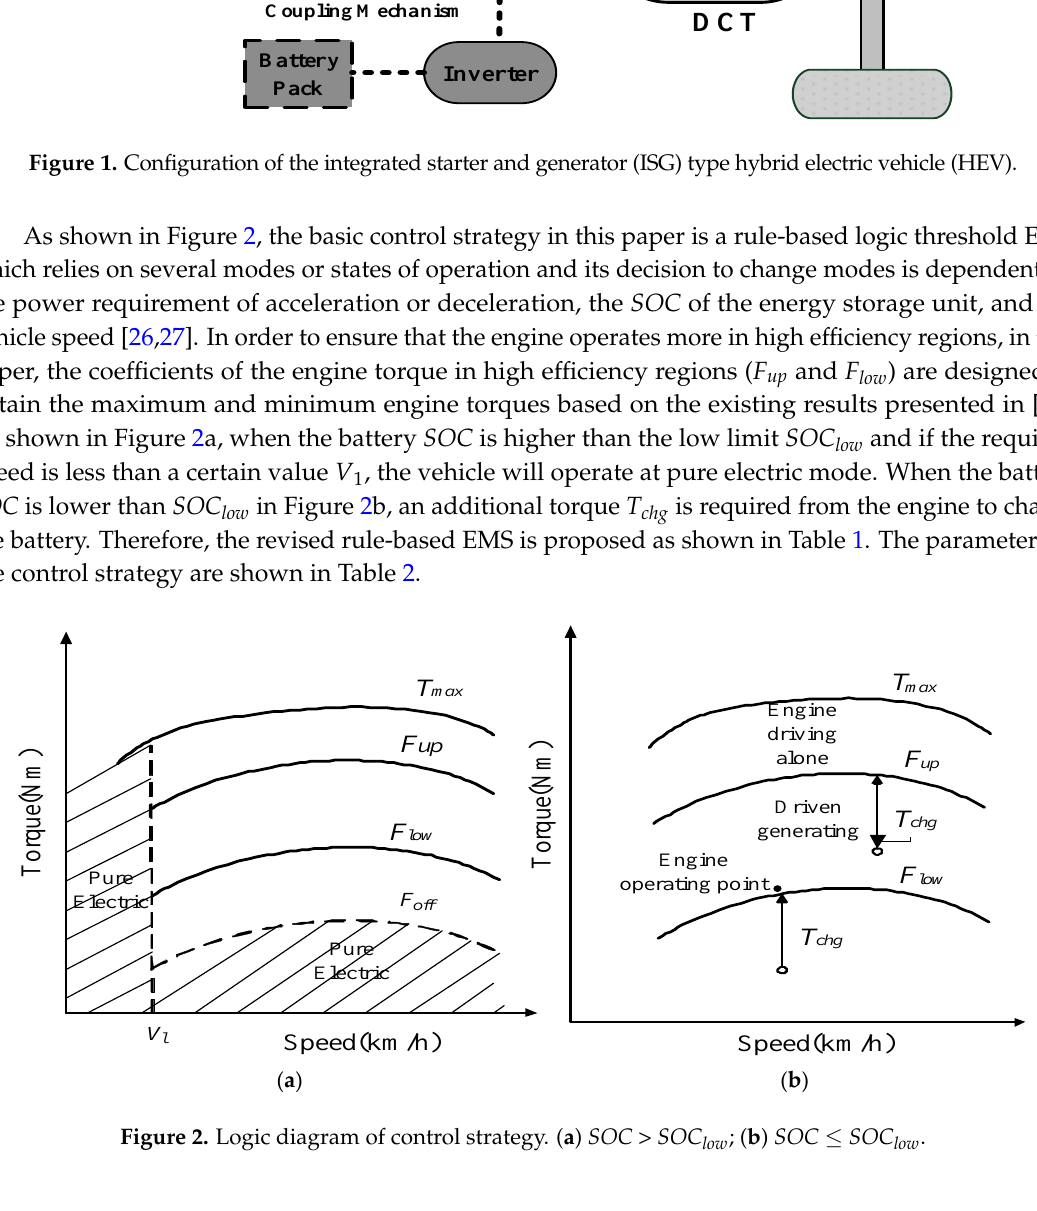
≤ SOC low ; ( b ) SOC low